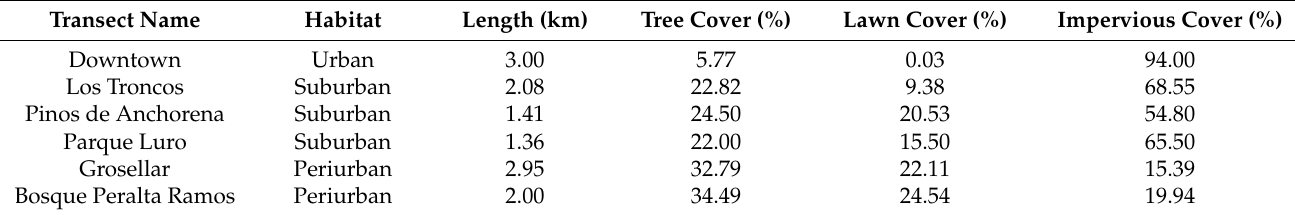
Table 1. Transects characteristics used for the long-term survey of Harris hawks in Mar del Plata city, Argentina. Percentage mean cover of trees, lawn, and impervious surfaces were obtained from 25 m radius points (see Leveau and Leveau [39]).